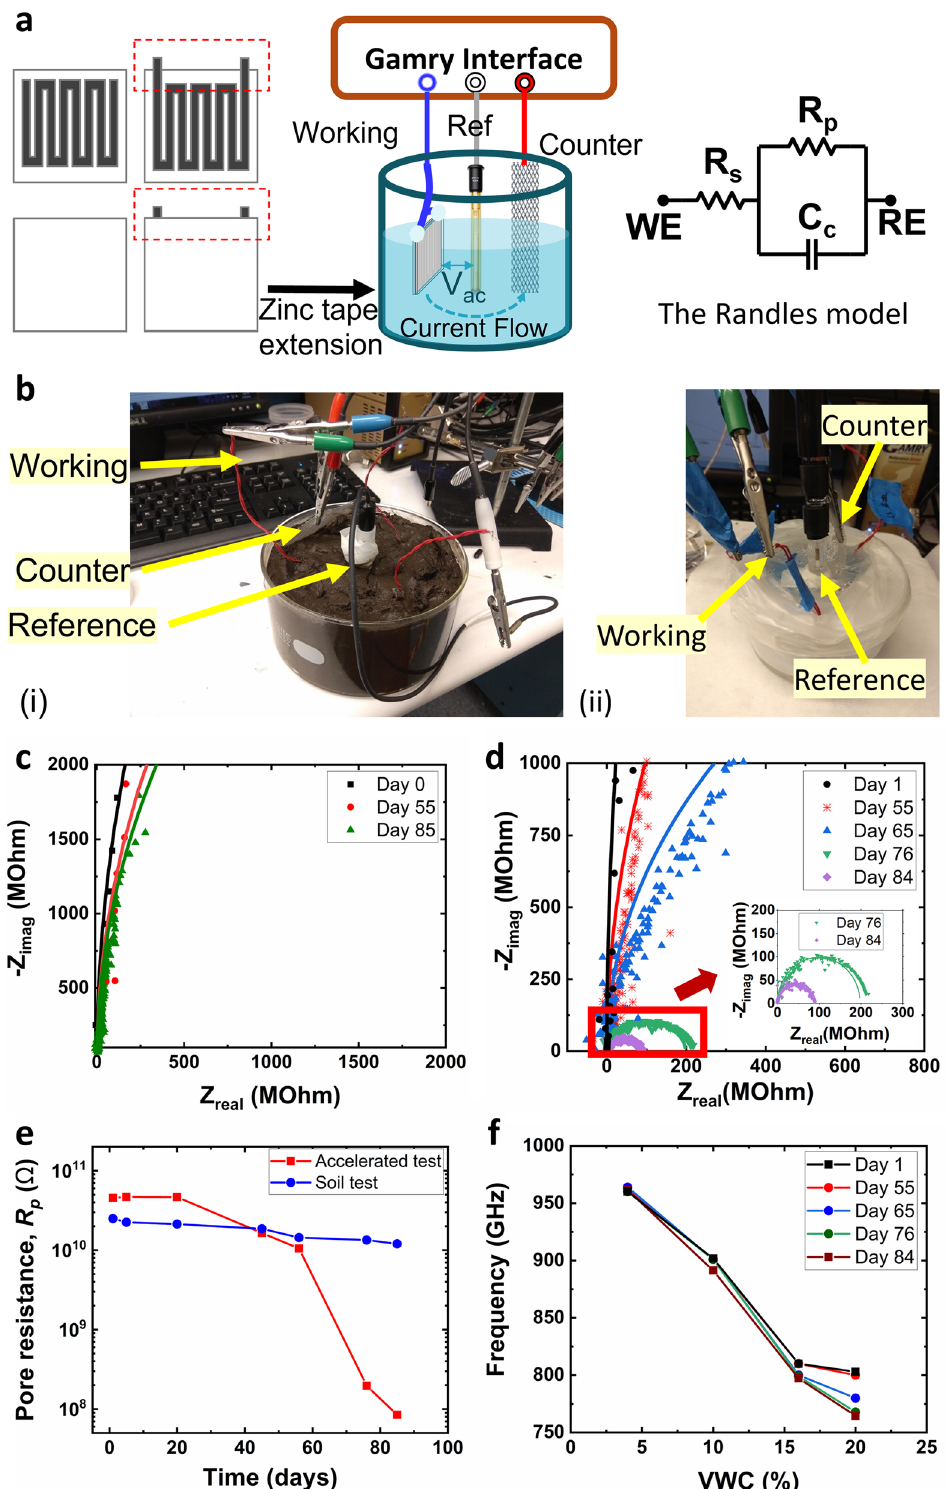
Figure 6. Experimental studies on biodegradation of DIRTS in an accelerated degradation environment and a soil environment ( a ) Conceptual illustration of the sensor tags modified for EIS measurements, the 3-electrode configuration for EIS measurements, and the Randles model used for impedance fitting. ( b ) Images of the experimental setups for (i) the soil test and (ii) accelerated test ( c ) Nyquist plots measured on various days when the sensor tags were in the soil. ( d ) Nyquist plots measured on various days when the sensor tags were in the accelerated degradation environment. The inset features the semicircle patterns on the Nyquist plots. ( e ) Extracted values of R p as a function of time for the soil test and the accelerated test. ( f ) Resonant peaks extracted from concurrent RF measurements plotted as a function of